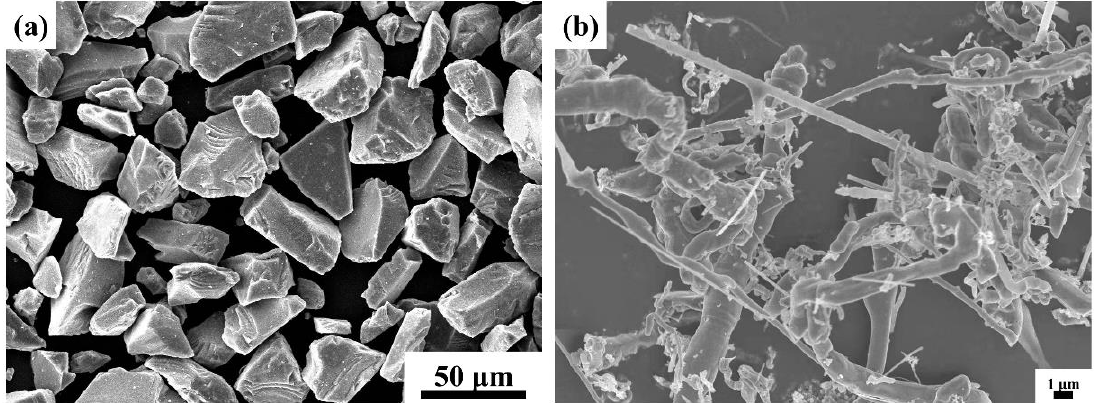
Figure 1. Microscopic morphology of additives: ( a ) SiC p ; ( b ) SiC w .